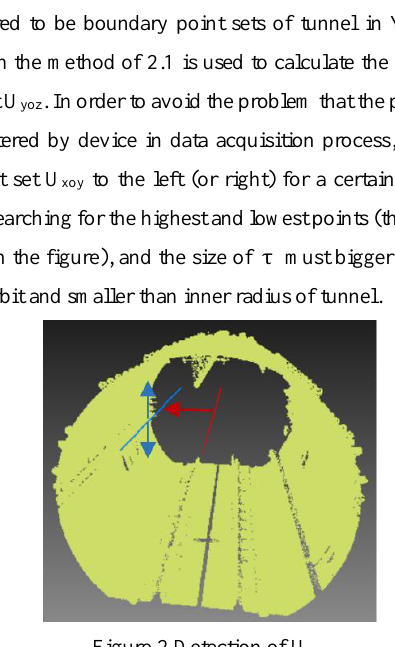
Figure 2 Detection of U